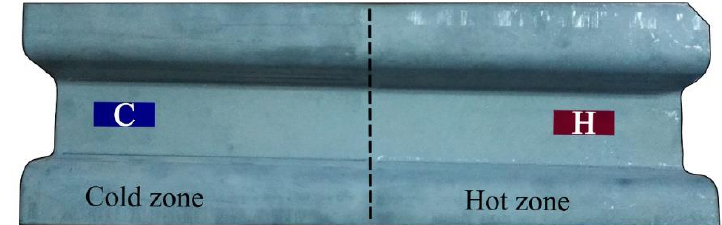
Figure 2. The cutting locations of specimens.